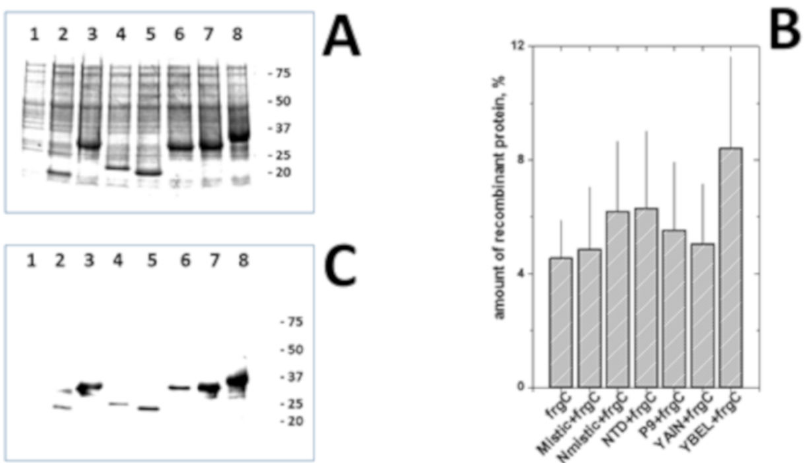
Figure 3. Coomassie-blue staining ( A,B ) and Western blotting ( C ) of anchor-motif + frgC 91–220 spinycterins grown and autoinduced in SB